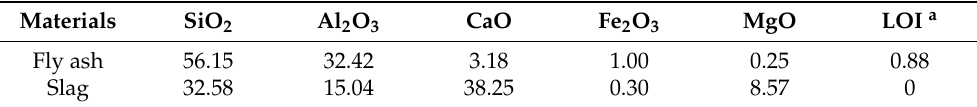
Table 1. Oxide composition and loss on ignition of raw materials (weight in %).